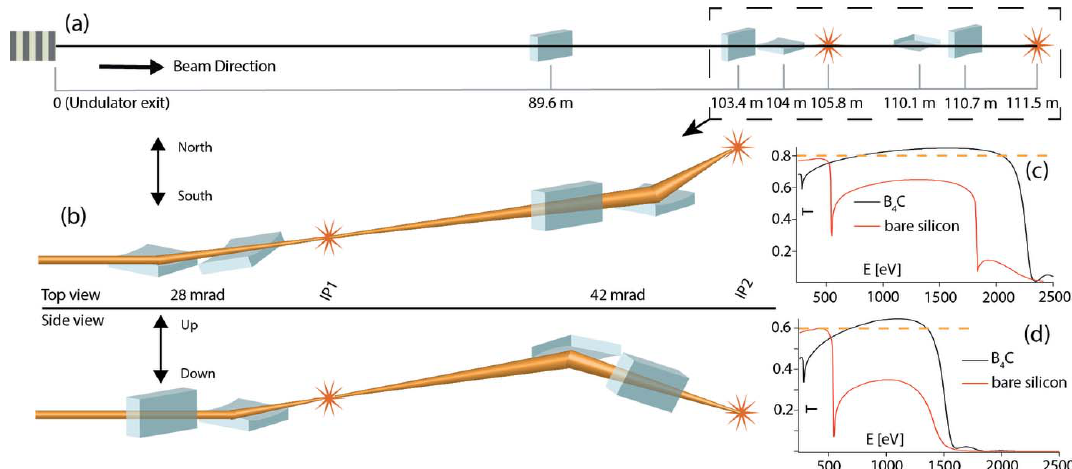
Figure 4 Overview of the TMO mirror layout. ( a ) The distances of each mirror and IP from the undulator in meters. The shown section inside the dashed line marks the TMO hutch where the KBO systems reside. ( b ) The dashed line section from ( a ) with the mirror orientations and deflection angle as top and side view. ( c ) The transmission ( T ) over the photon energy ( E ) for IP1 for both mirror coatings. ( d ) The transmission ( T ) over the photon energy ( E ) for IP2 also for both mirror coatings. A horizontal dashed line indicates the design goal for the reflectivity after all the mirrors; it is 80% for IP1 and 60% for